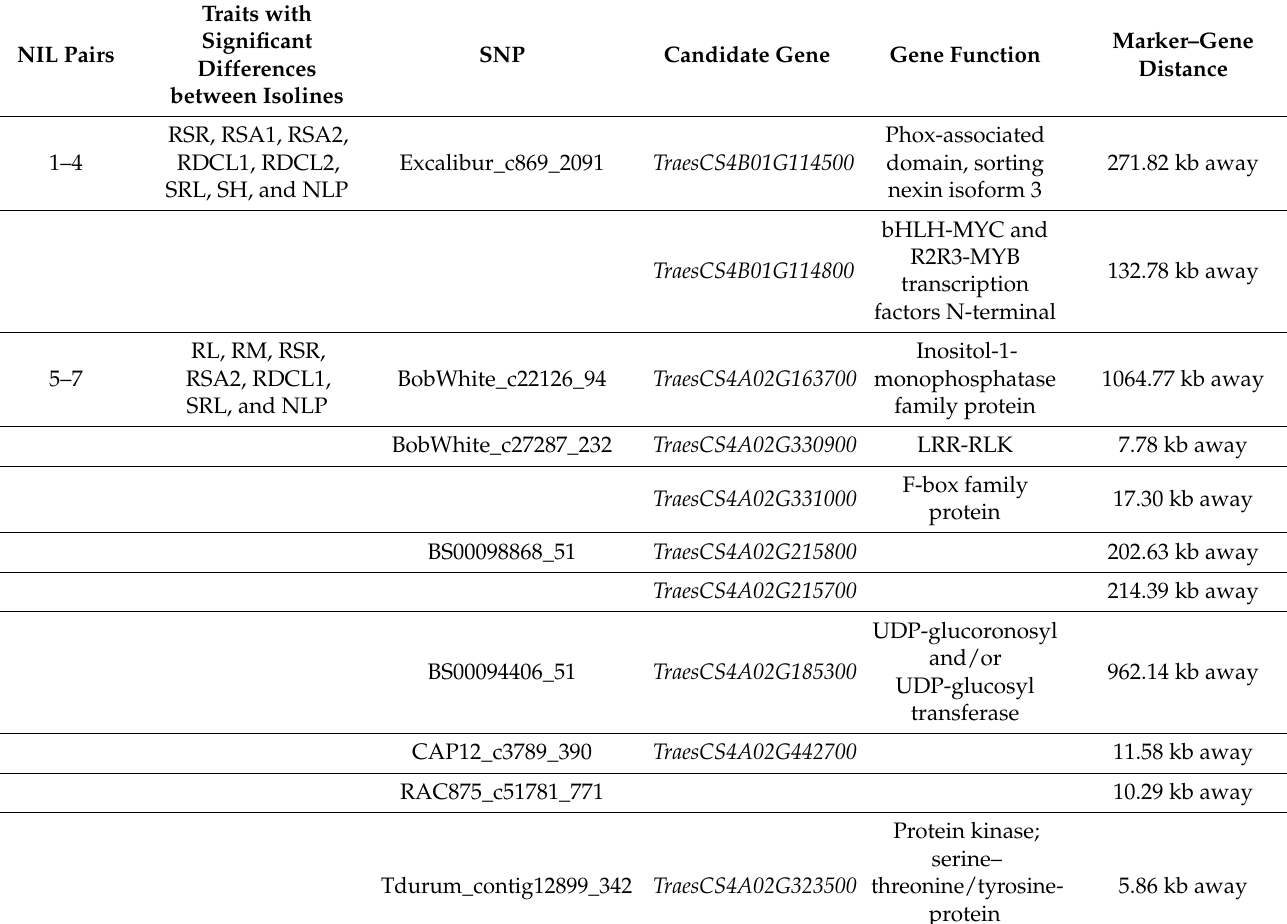
Table 3. Candidate genes identified in the targeted QTL regions are strongly suggested to be responsible for the tested root and shoot traits in the nine pairs of wheat near-isogenic lines (NILs) used in this study.